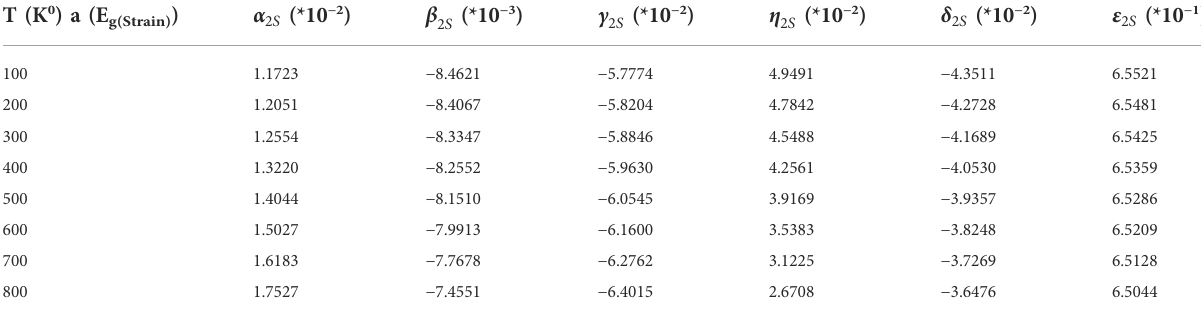
TABLE 3 Fitting parameters for “ a ” the under strained condition at different